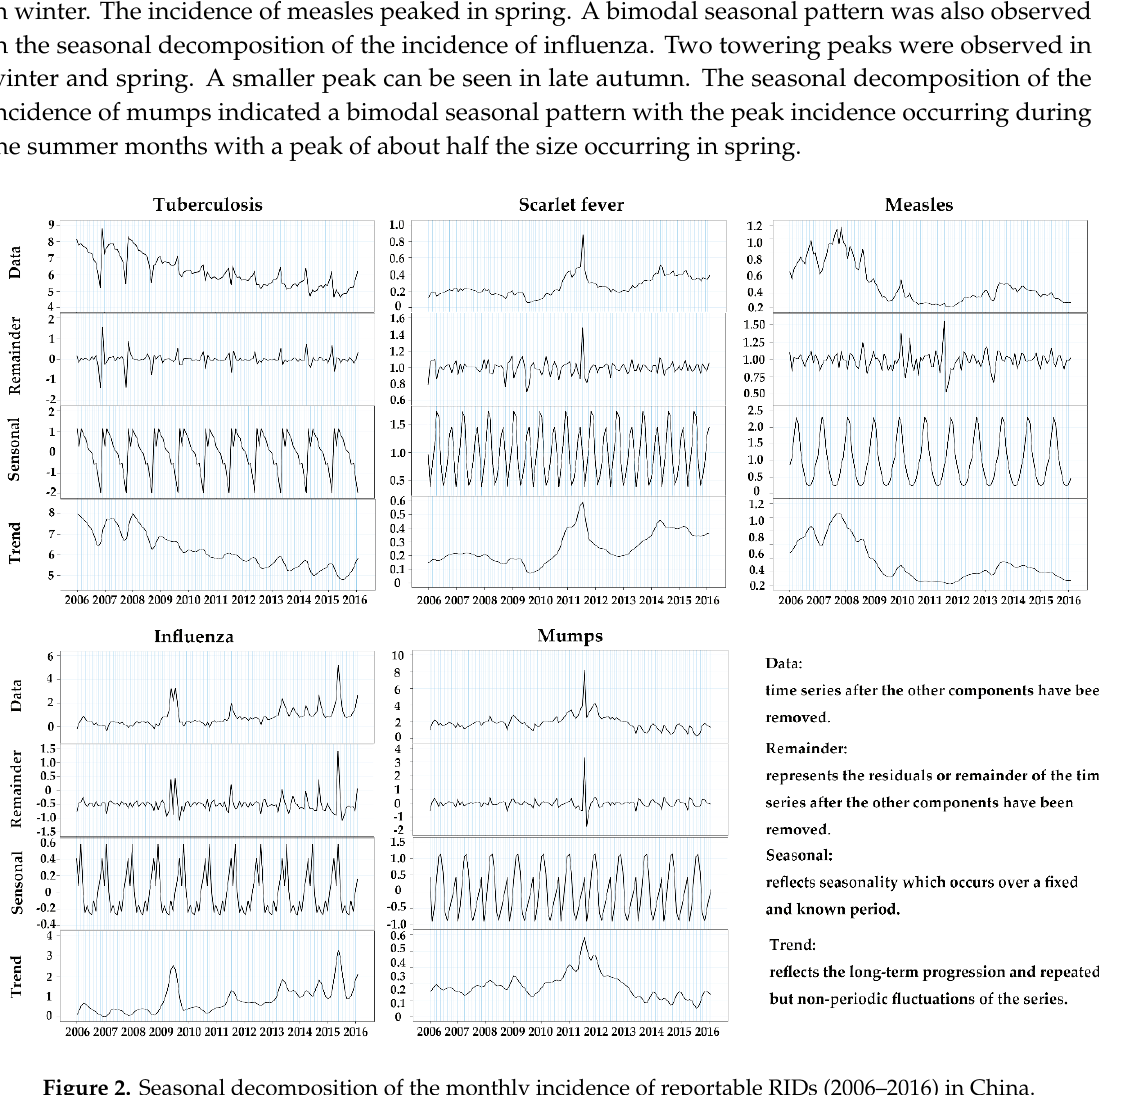
Figure 2. Seasonal decomposition of the monthly incidence of reportable RIDs (2006–2016) in China.